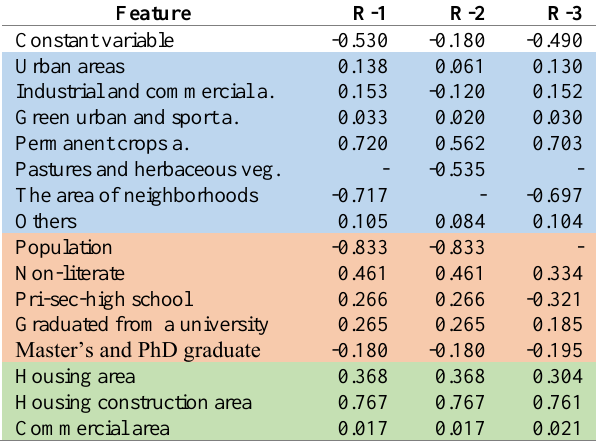
Table 4. Multiple linear regression models and variable